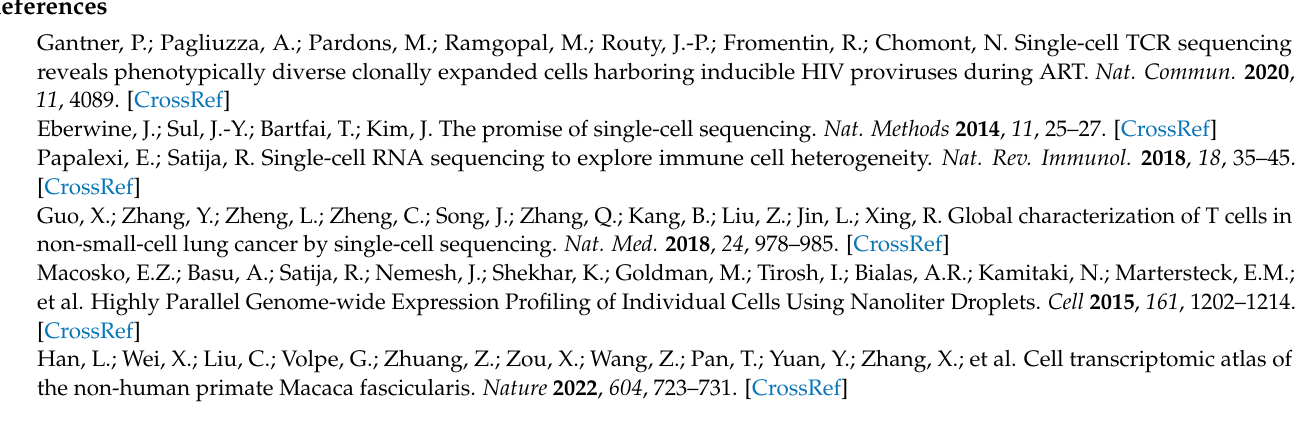
for the identification of TCR-T cells; Figure S5: Sorted droplet collector; Figure S6: Statistics of the droplet diameter on different conditions; Figure S7: Principle and verification of nucleic acid capture; Figure S8: Qualification of 1000-cell samples by RNA sequencing; Figure S9: UMAP of cells from different samples; Figure S10: Cell cycle analyses of TCR-T cells; Figure S11: The strategy of next work in antigen-specific TCR recognition; Table S1: Materials; CAD-1: Droplet sorting chip-Chip